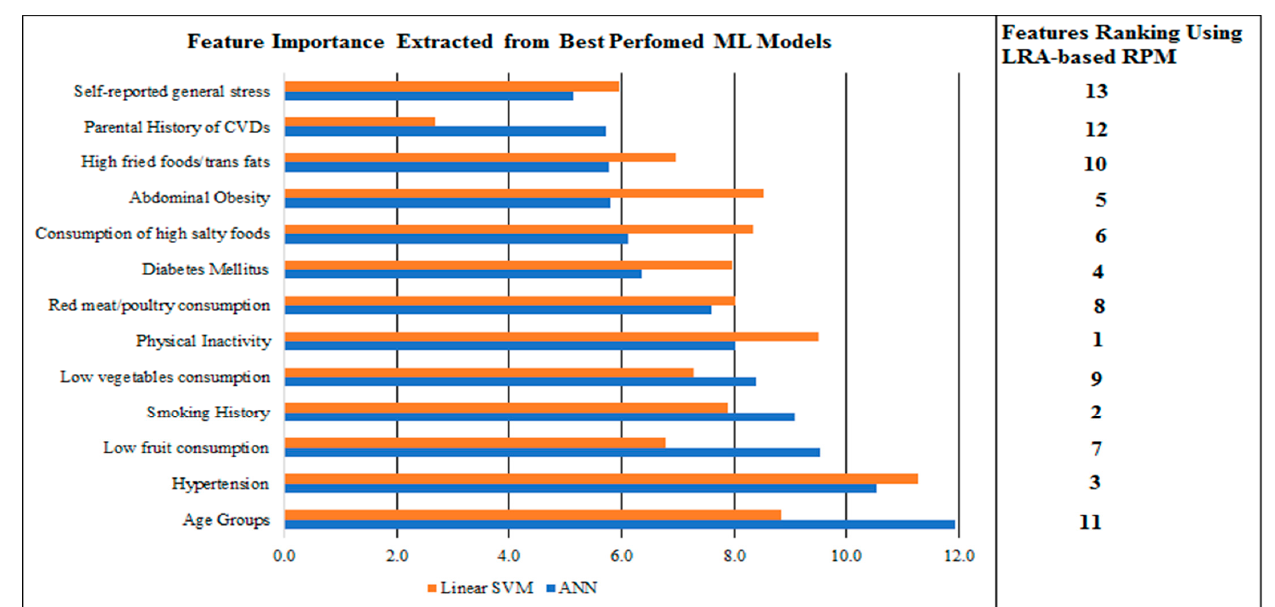
Figure 3. Relative feature importance extracted through best-performed ML and baseline RPMs.